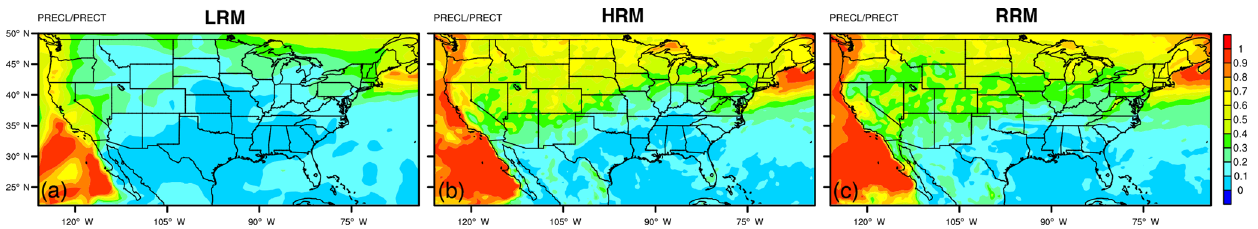
Figure 12. Mean ratio of large-scale to total precipitation in JJA for (a) LRM, (b) HRM, and (c) RRM.